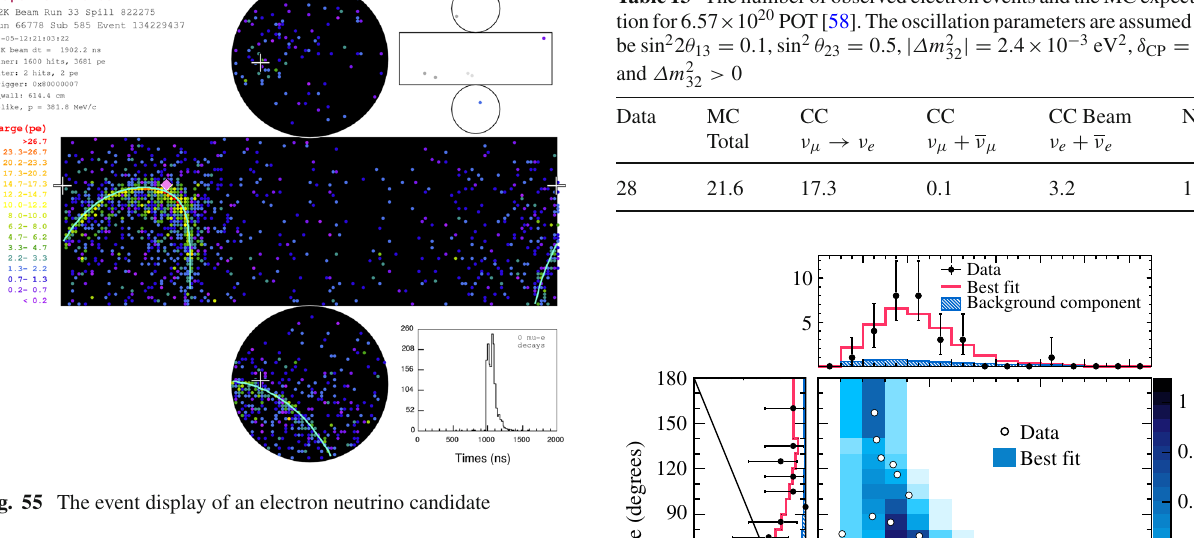
Table 13 The number of observed electronevents and the MC expecta- tionfor6 . 57 × 10 20 POT[58].Theoscillationparametersareassumedto